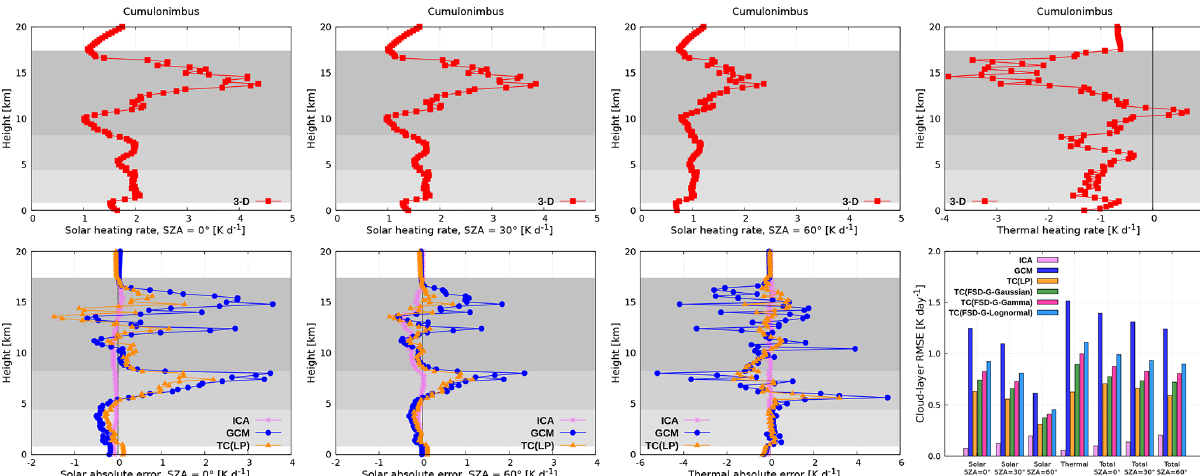
Figure 11. Radiative heating rate for the cumulonimbus cloud. The gray-shaded area denotes the cloud layer. The liquid region is shaded light gray, the mixed-phase region is shaded middle gray, and the ice region is shaded dark gray.